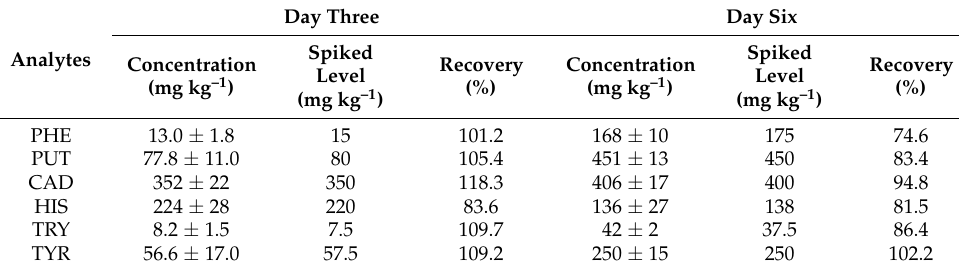
Table 4. Recovery of biogenic amines in mackerel on day three and six.